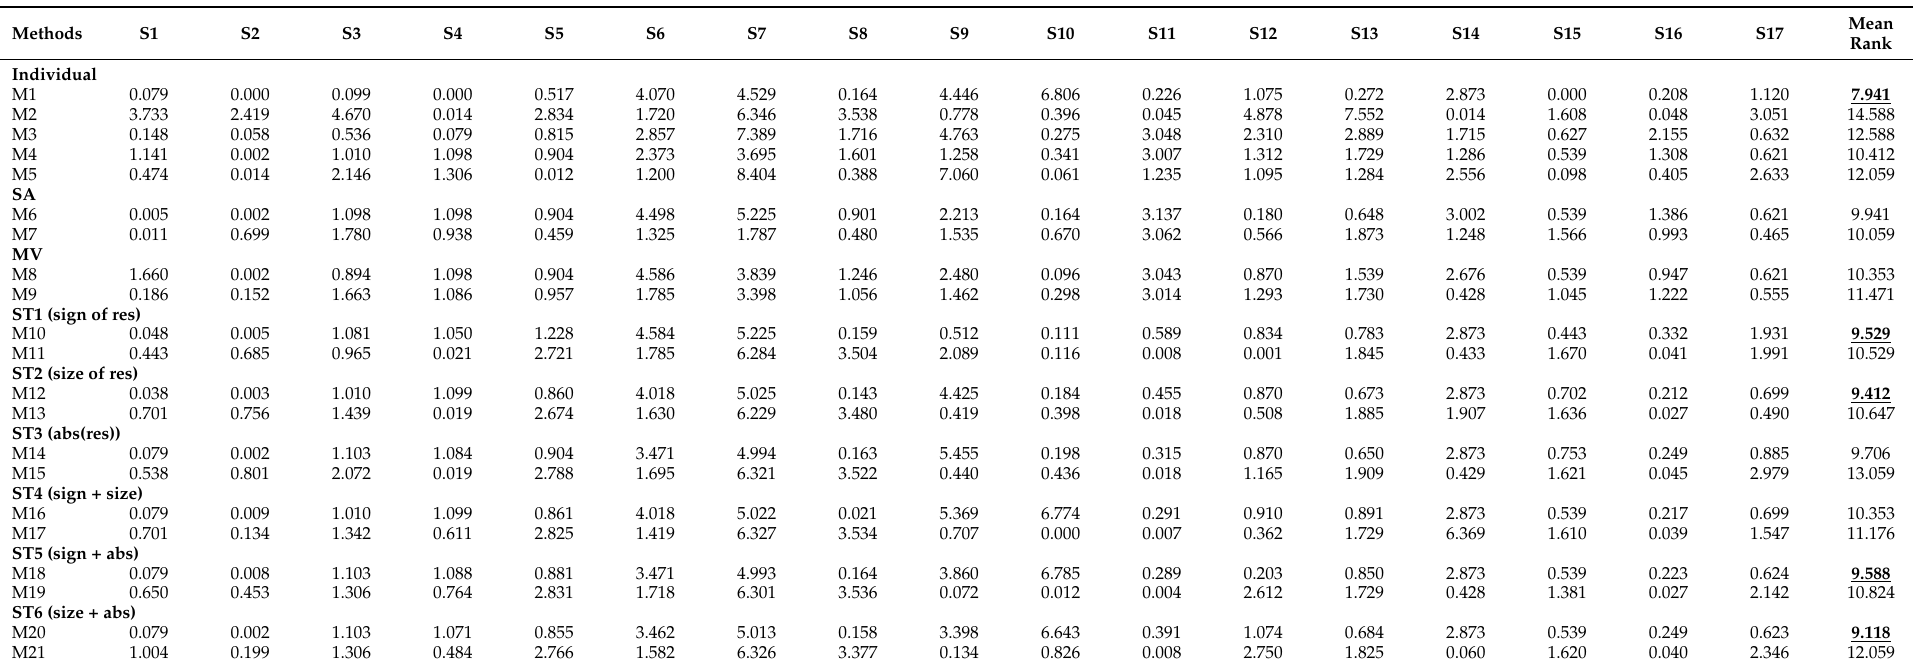
Table 15. R 2 for out-of-sample in tourism demand volatility